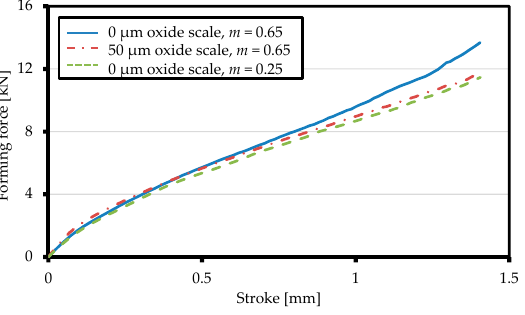
Figure 11. Numerically-calculated force–displacement curves for ring compression tests of variants with and without oxide scale for different friction factors.